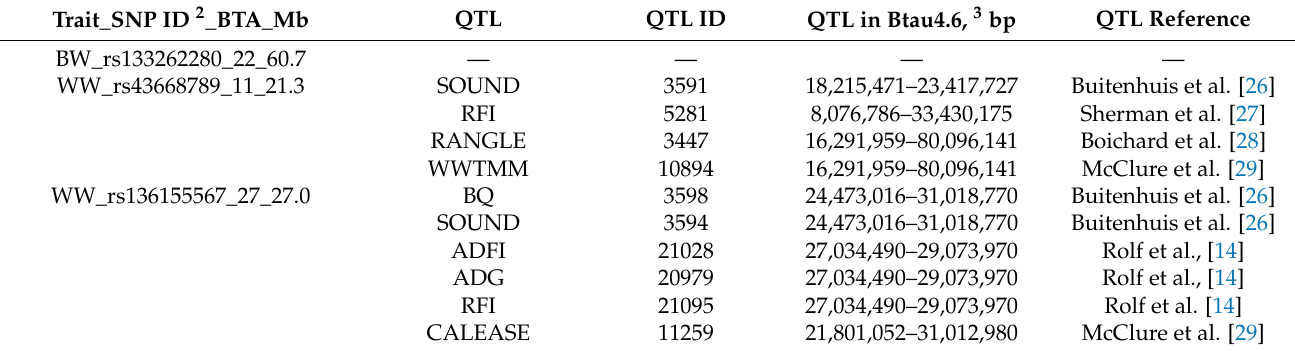
Figure 3. Manhattan plots of the p -values for the genome-wide association study of birth, weaning and yearling weights of Braunvieh cattle. The horizontal line indicates the significance threshold for significant associations ( p < 5 × 10 − 5 ). Blue and orange differentiate chromosomes. Table 3. Previously reported QTL1 found near the SNP associated with growth traits of Braunvieh cattle.